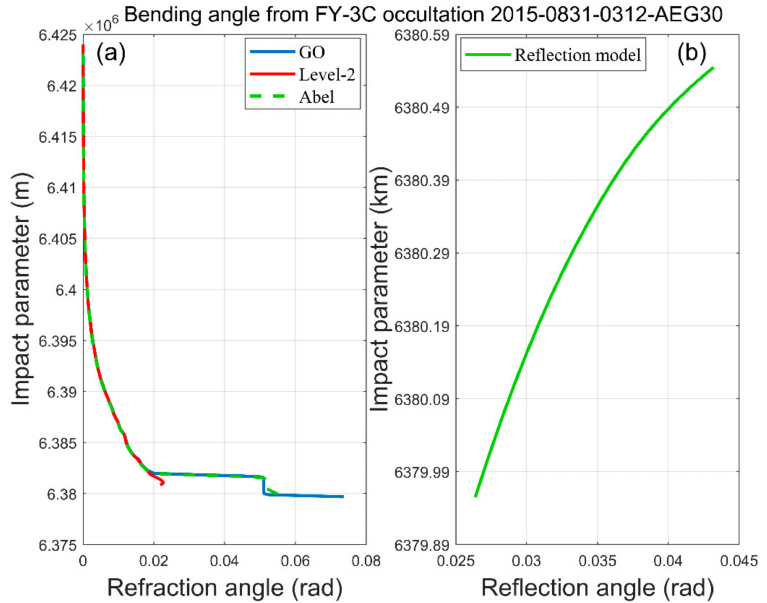
Figure 8. Bending angles of FY-3C event on 31 August 2015: in ( a ), the red curve shows the bending angles of refractivity profile from cutting height to 40 km altitude, the green dashed curve shows the bending angles by Equation (6) and the blue curve shows the recalculated bending angle by GO method from Earth’s surface to 40 km altitude; ( b ) shows the reflected bending angle model extracted by Equation